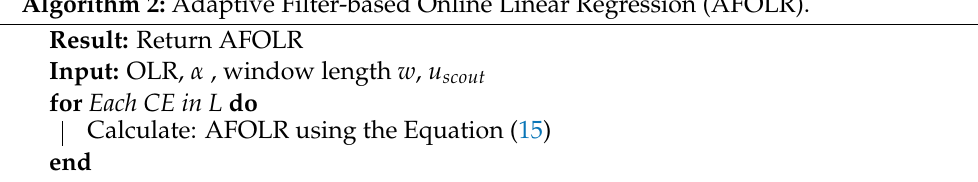
Algorithm 2: Adaptive Filter-based Online Linear Regression